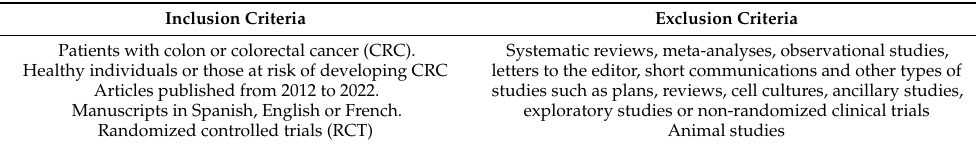
Table 1. Inclusion and exclusion criteria. Inclusion